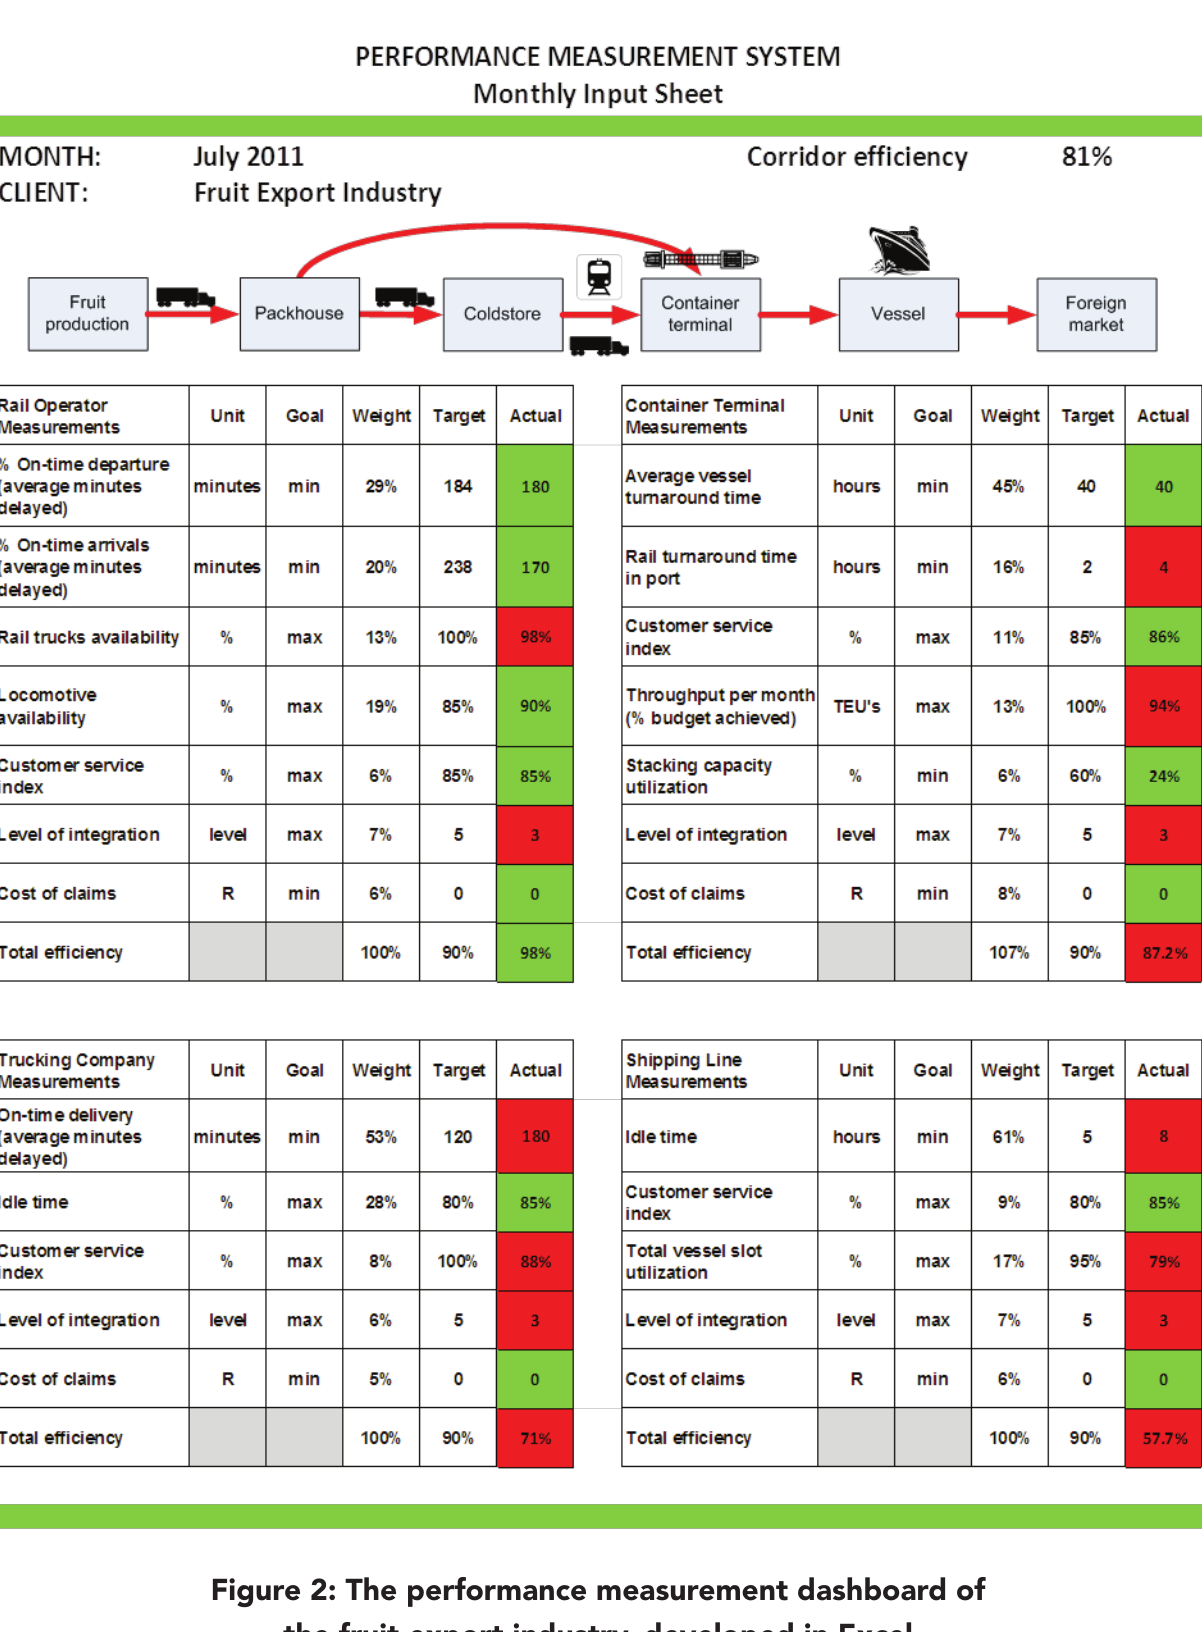
Validation of the